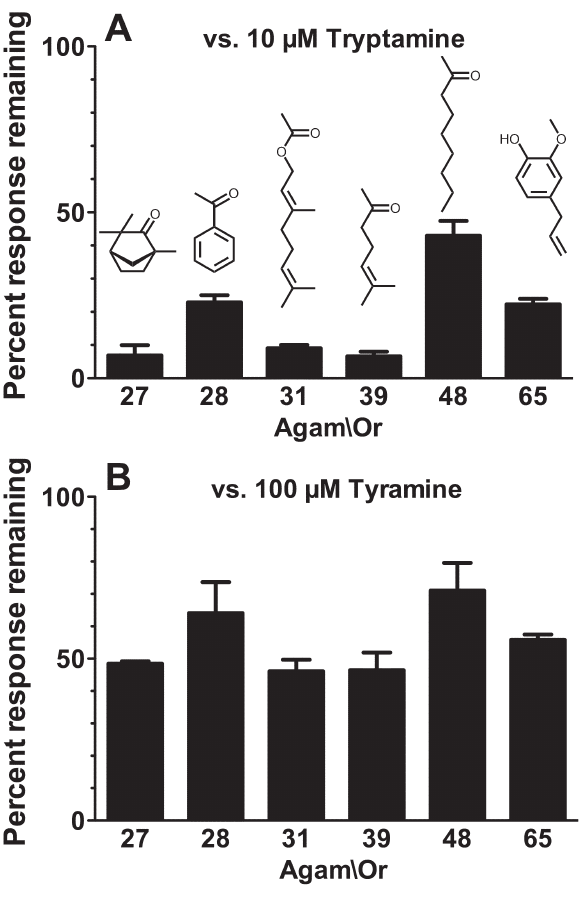
Figure 6. Tryptamine and tyramine inhibit odorant activation of multiple Agam\ORs. Current responses of oocytes expressing Agam\Orco+Agam\Or27 (activated by 3µM L-fenchone), Agam\ Orco+Agam\Or28 (activated by 40µM acetophenone), Agam\ Orco+Agam\Or31 (activated by 70µM geranyl acetate), Agam\ Orco+Agam\Or39 (activated by 10µM 6-methyl-5-hepten-2-one), Agam\Orco+Agam\Or48 (activated by 3µM 2-nonanone), or Agam\ Orco+Agam\Or65 (activated by 100nM eugenol) in the presence of 10µM tryptamine ( A ) or 100µM tyramine ( B ) were compared to the preceding response to odorant alone and are presented as mean ± SEM (n = 3). Odorant structures are